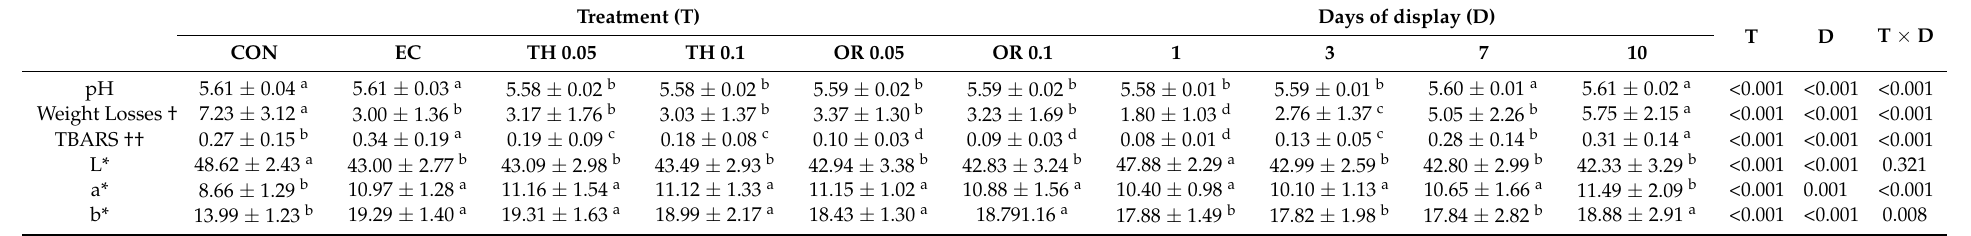
Table 2. Meat characteristics of lamb patties with an edible coating and essential oils (EO) during the display period (mean ± standard